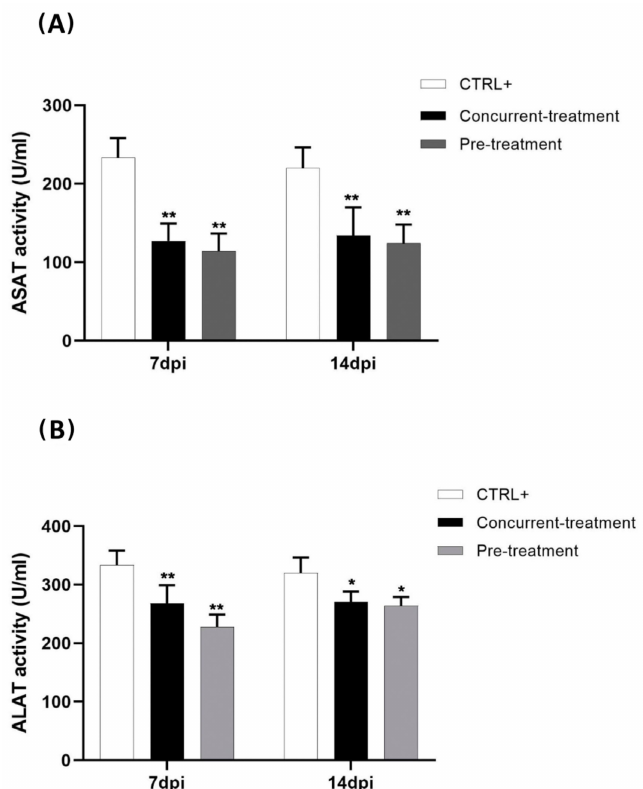
Figure 6. Favipiravir decreases serum ASAT ( A ) and ALAT ( B ) levels in MAYV-infected mice. Hepatic enzyme levels were quantified in MAYV-infected C57BL/6 mice treated ( n = 4) or not ( n = 6–8) with Favipiravir at 7 and 14 dpi. The data are expressed as the mean ± SEM. * p < 0.05; ** p <